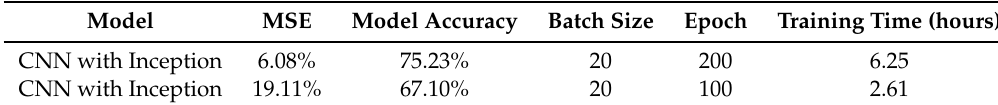
Table 3. Results of loss and model accuracy for a varying number of epochs with integrating the Inception model.